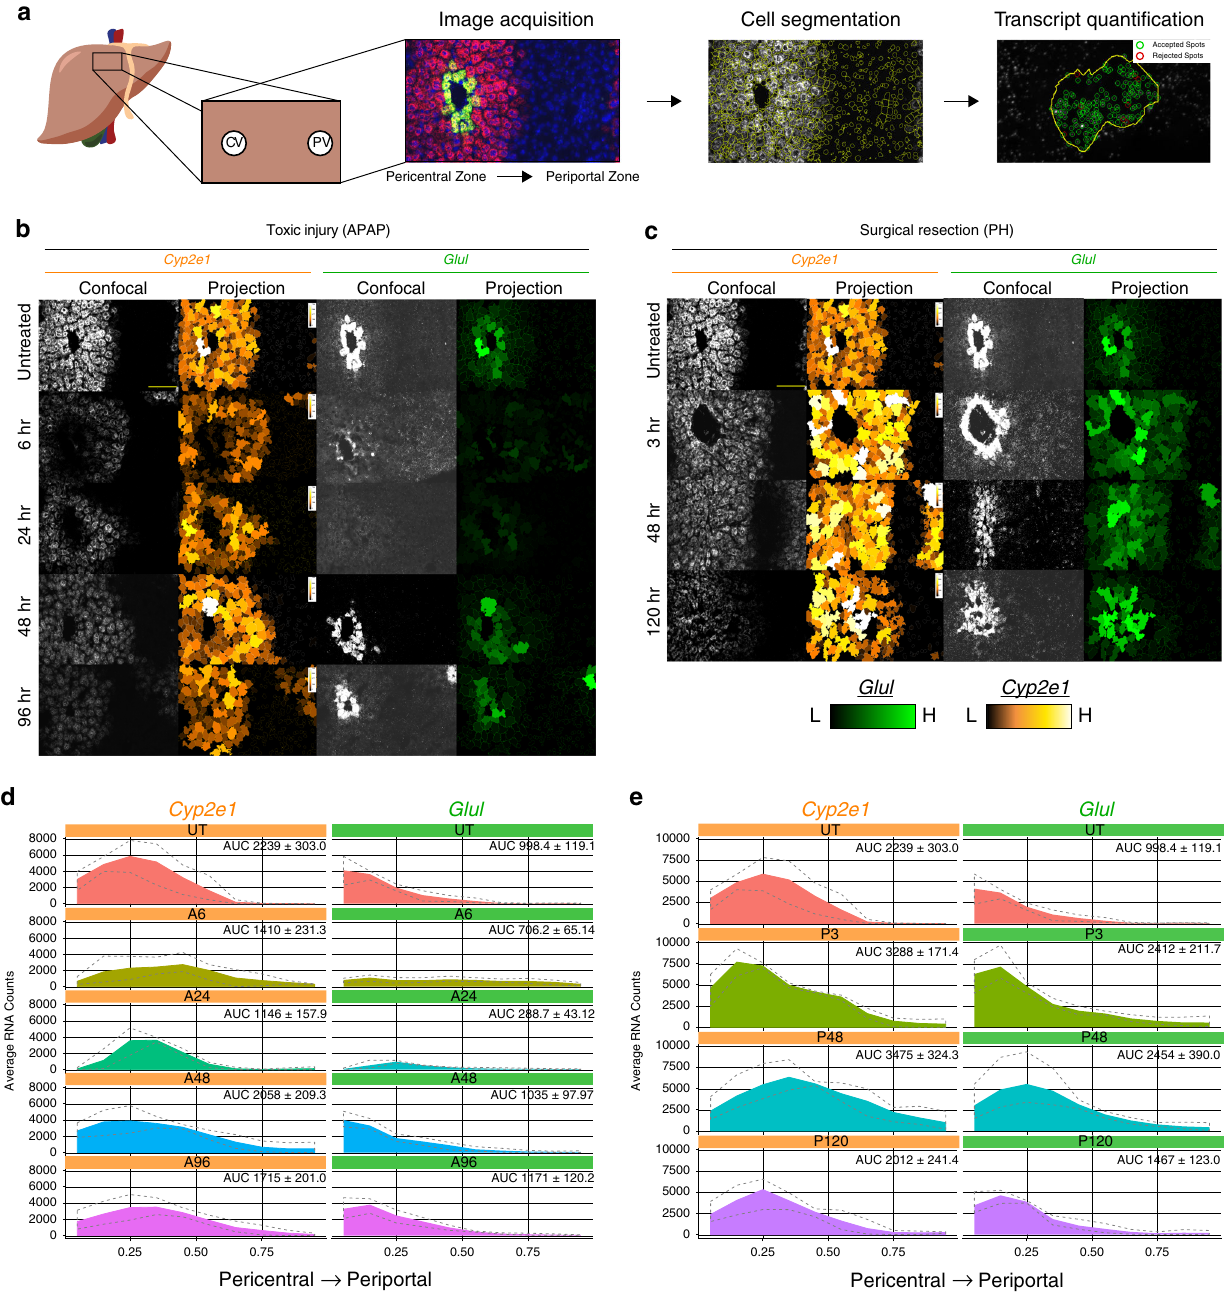
Fig. 2 Functional compensation of hepatocytes following acute liver injury. a Schematic for staining and image quanti fi cation. b , c Images of liver section showing pericentral markers Cyp2e1 and Glul for untreated and each APAP-treated ( b ) or PH-treated ( c ) time point (left column). Cell outlined and colored by number of Cyp2e1 transcripts (brown, low; white, high) for each condition (middle column). Cell outlined and colored by number of Glul transcripts (black, low; bright green, high) for each condition (right column). Scale bars are 100 μ m. d , e Quanti fi cation of gene expression intensity across the lobule for Cyp2e1 and Glul . 90% of area under the curve (AUC) for UT is to the left dashed red line. treated ( d ) and PH-treated ( e ). Source data provided as a Source Data fi